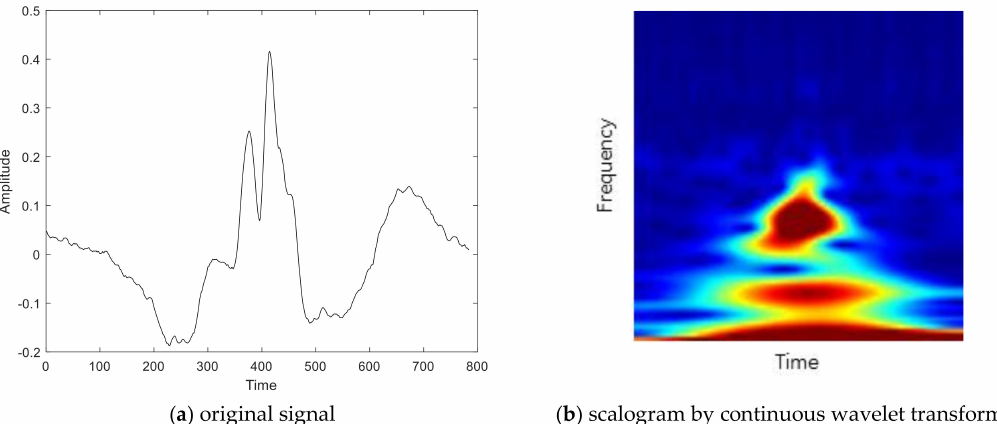
Figure 5. Scalogram of an electrocardiogram.